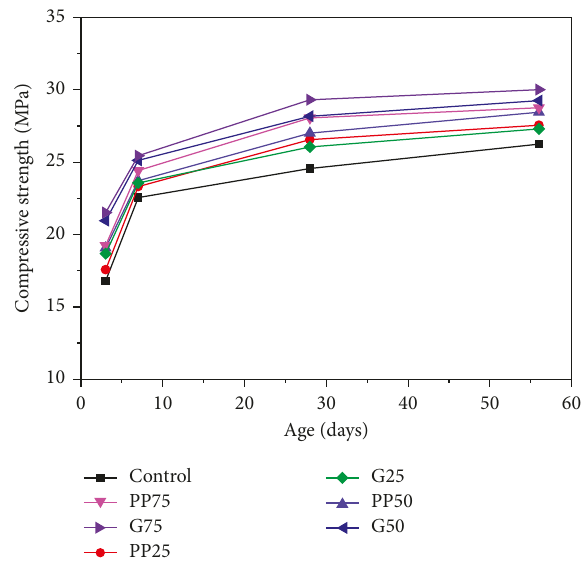
Figure 5: The development of the compressive strength of